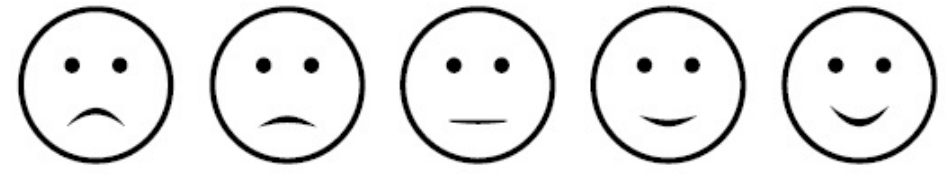
Figure 1. Hedonic scale.